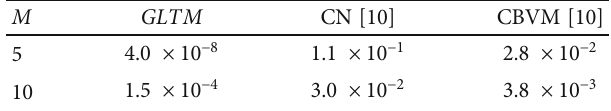
Table 5: Comparison of MAEs of Example 7.